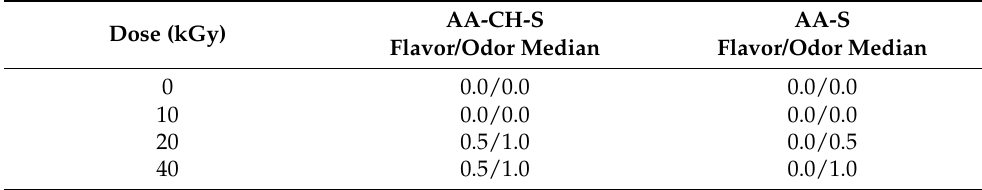
Table 2. Sensory analysis of AA-CH-S and AA-S